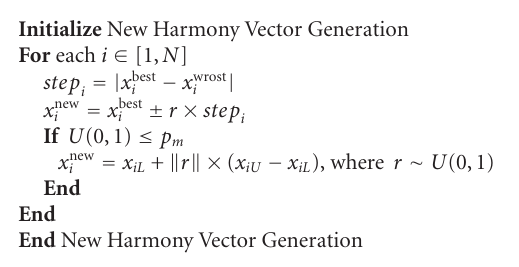
Pseudocode 1: New harmony vector generation procedure of NGHS in